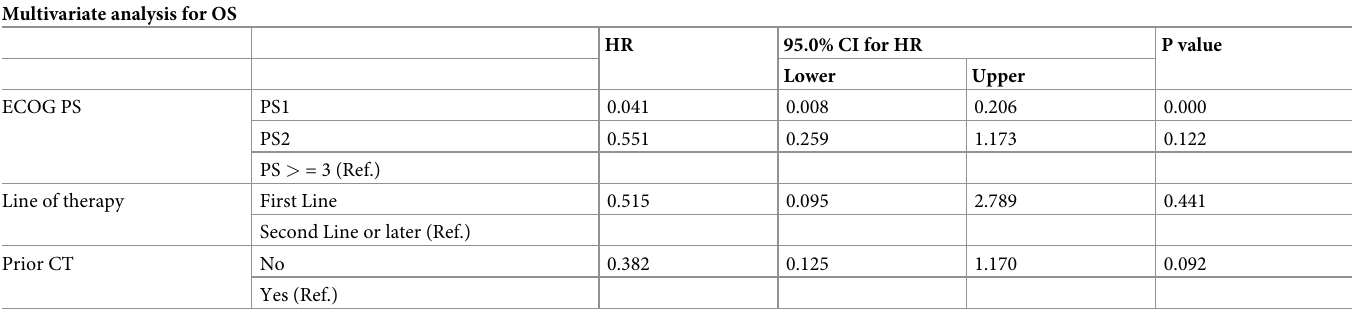
Table 6. Multivariable analysis of overall survival. Multivariate analysis for